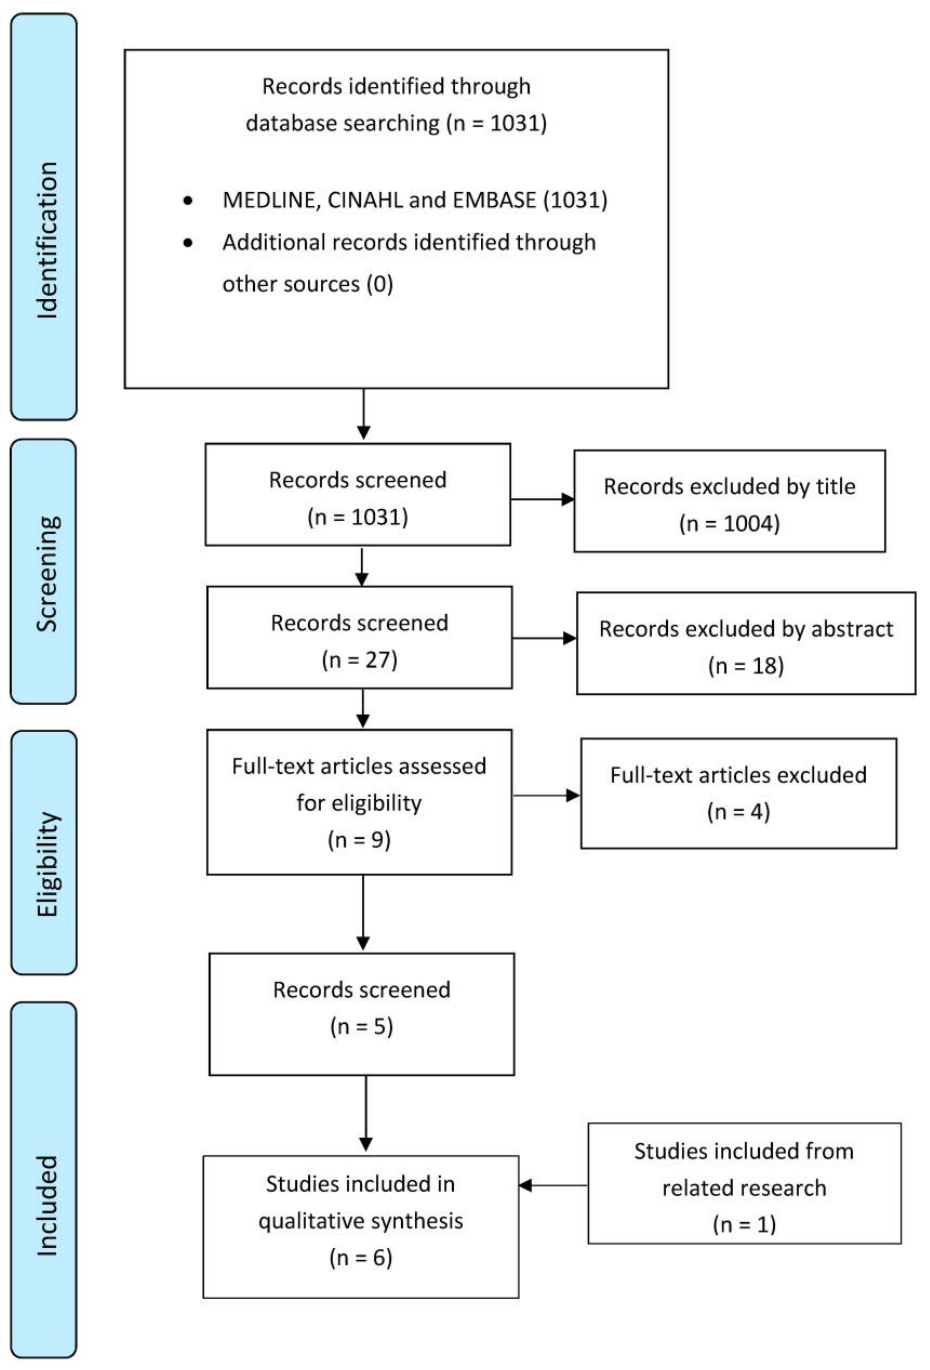
Figure 1. PRISMA Flow Figure 1 . PRISMA Flow diagram.